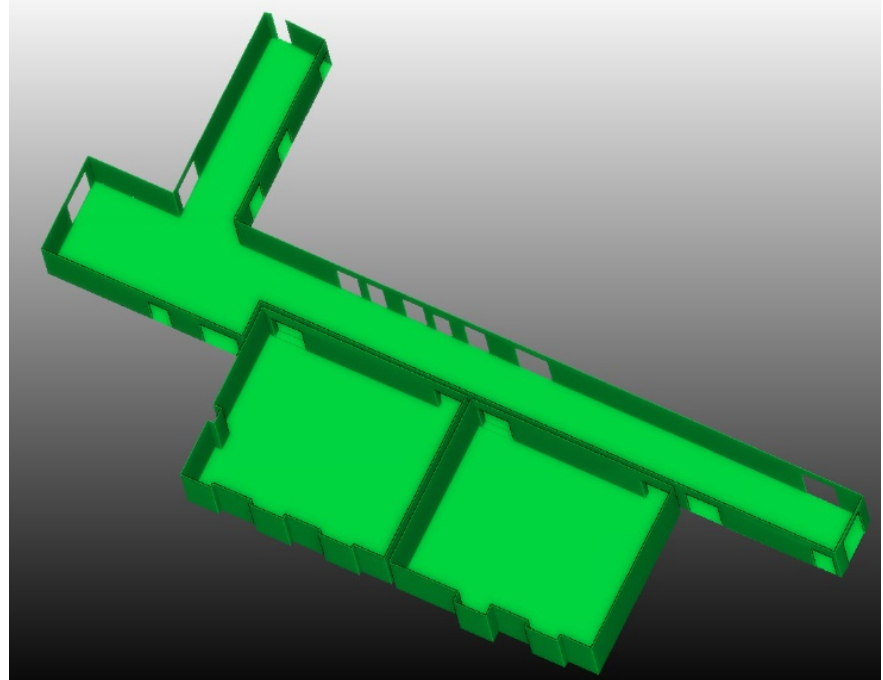
Figure 13. Three-dimensional geometric model of Site 1 with all the doors being successfully mod- elled (ceilings were removed for better